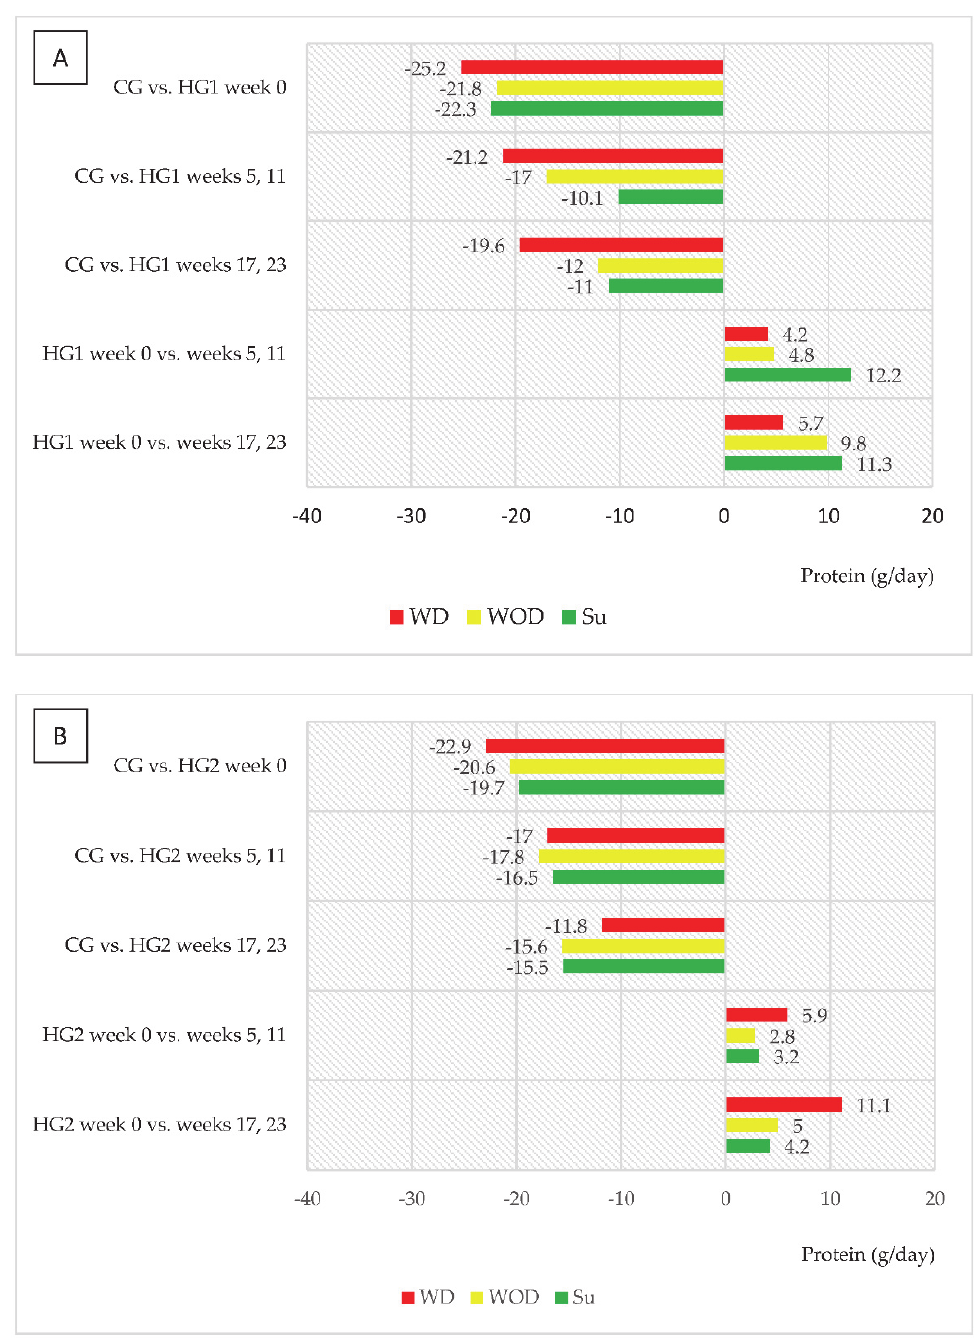
Figure 3. ( A , B ) Differences between daily protein intake (g/d) in comparison to the control group (CG) and in comparison to baseline values (week 0). ( A )—data regarding patients who were to comply with the dietary recommendations without a meal served before dialysis (HG1); ( B )—data regarding patients who were to comply with the dietary recommendations with a meal served before dialysis (HG2); other abbreviations as in Figure 2.